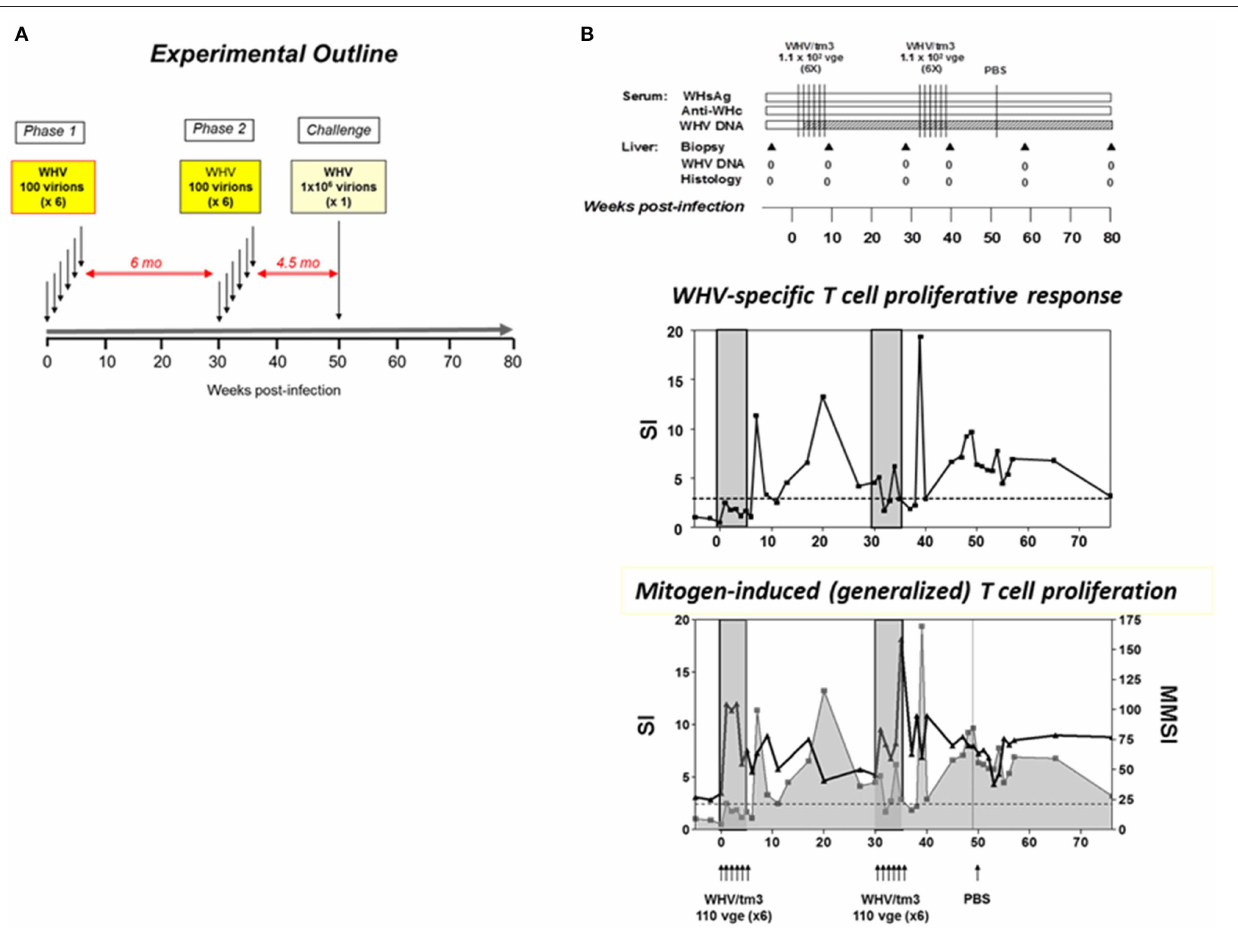
FIGURE 3 | Outline of the study investigating virological, immunological and liver injury outcomes in woodchucks injected with multiple liver-nonpathogenic doses of WHV. (A) Four WHV-naïve, healthy animals were intravenously injected with 6 weekly doses of 110 WHV virions (Phase 1). Six months later they were challenged with another 6 weekly doses of 110 virions each of the same virus (Phase 2). The total quantity of the virus administered was 1,320 virions and cumulatively exceeded a liver pathogenic dose of 1 × 10 3 virions. Three-and-half months later, the animals were re-challenged with either a liver pathogenic dose of 1.1 × 10 6 virions of the same virus or injected with sterile PBS as controls (Challenge). (B) An example of the outcomes investigated in a woodchuck subjected to two rounds of injections with 6 weekly 110-viron doses of WHV and then injected with PBS. The data showed the lack of appearance of serologically detectable infection, including absence of anti-WHc antibodies which are very sensitive indicator of exposure to WHV, or hepatitis (upper panel). WHV-specific T cell response (middle panel) was preceded by ConA-induced, generalized T cell proliferation (lower panel). For details and abbreviations, see the legend to Figure 4 . Figures adopted with modifications from Gujar et al. (